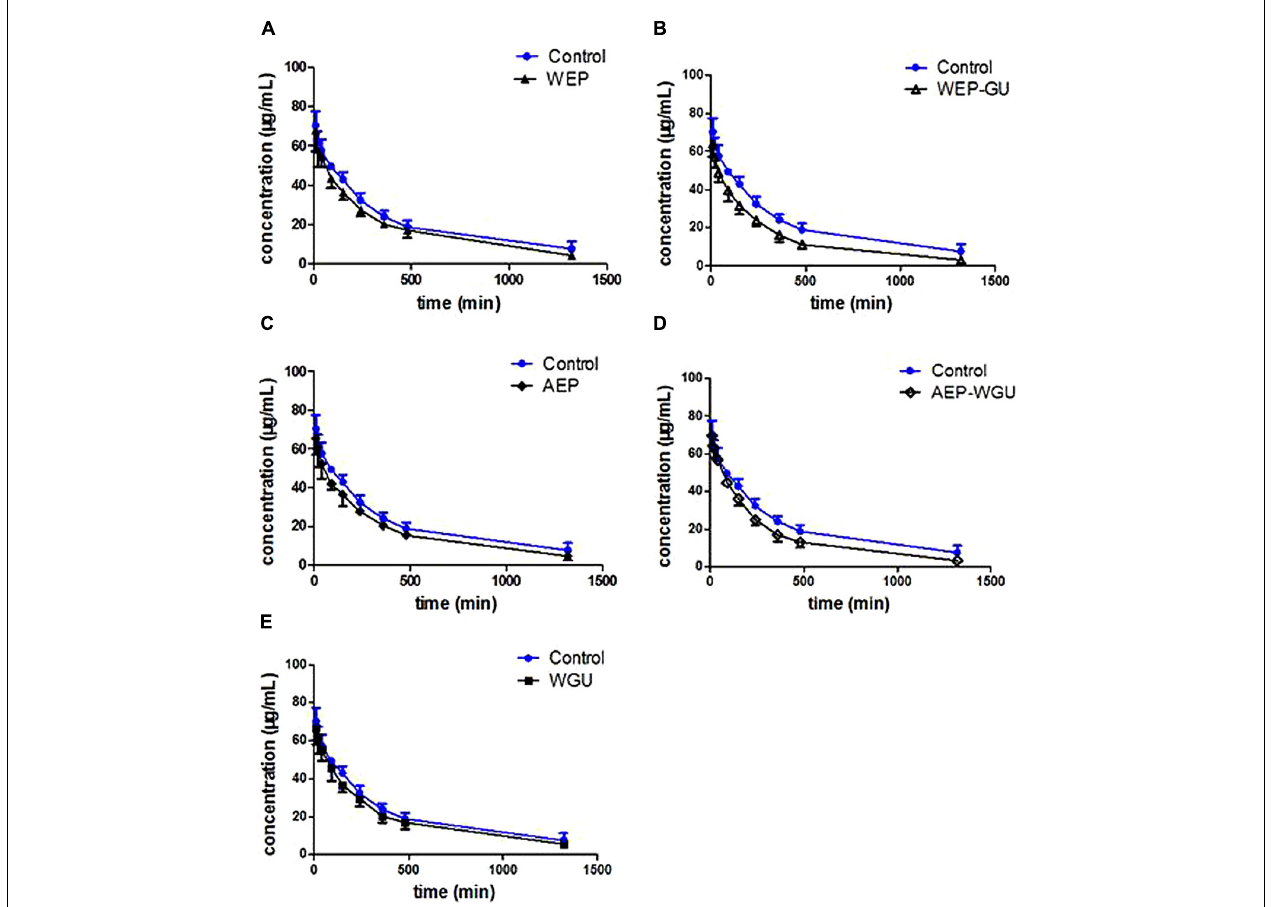
FIGURE 1 | Mean plasma concentration–time curve of tolbutamide after treatment. (A) Control andWEP; (B) Control andWEP-GU; (C) Control and AEP; (D) Control and AEP-WGU; (E) Control andWGU; ( ¯ x ± s, n = 6).